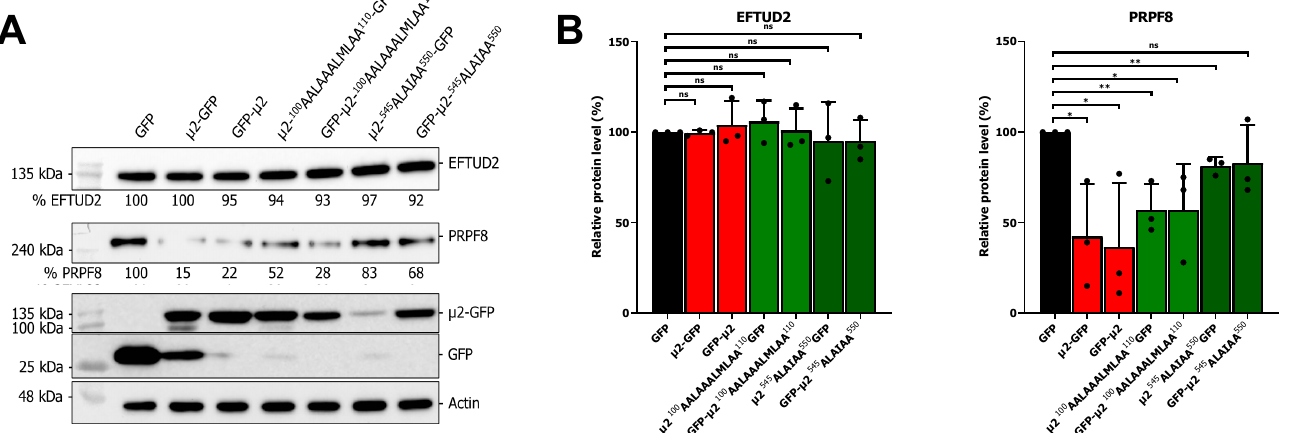
Figure 4. Nuclear localization of µ 2 is dispensable for its effect on U5 snRNP protein levels: ( A ) WB of EFTUD2 and PRPF8 upon expression of GFP, µ 2-GFP, or mutants of µ 2 unable to accumulate in the nucleus for 48 h. Relative quantification is shown in comparison to the GFP alone condition; and ( B ) quantification of three independent WB for EFTUD2 and PRPF8 protein levels. n = 3, biological replicates, unpaired two-tailed Student’s t -test (ns, p > 0.05; *, p ≤ 0.05; **, p ≤ 0.01) comparing with the GFP condition. Results presented are mean ± standard